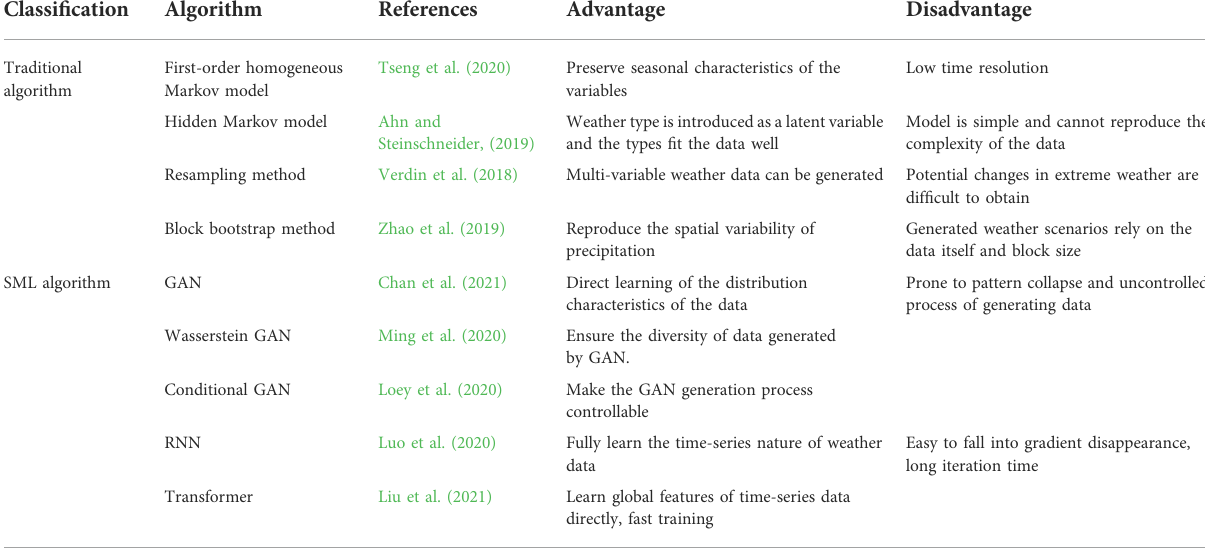
TABLE 1 Comparison of weather simulation